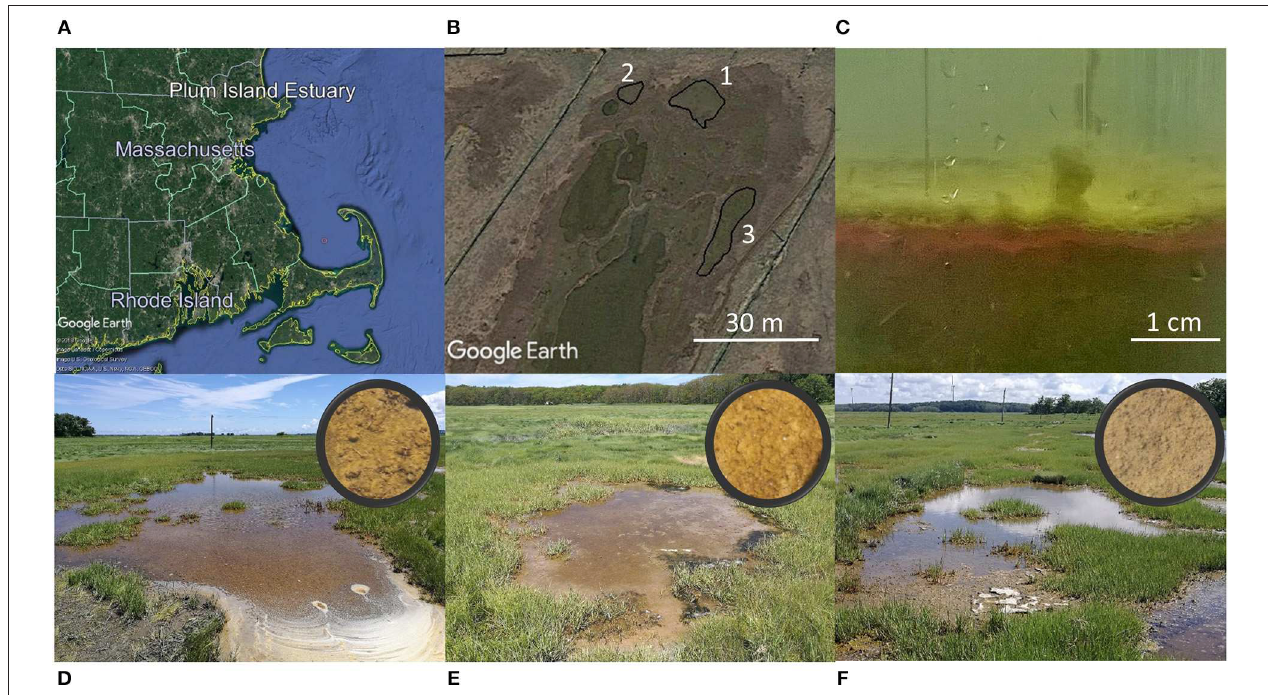
FIGURE 1 | Study site. (Top panel) Plum Island Estuary in Massachusetts, USA (Image: © 2018 Google. Image Landsat/Copernicus. Image U.S. Geological Survey. Data SIO, NOAA, U.S.Navy, NGA, GEBCO) (A) . Investigations were conducted in three closely located tidal ponds (image from Google Earth) (B) . A thick layer of photosynthesizing benthic microalgae covered the bottom of the tidal ponds (C) . (Bottom panel) The three ponds investigated are located on the marsh platform. Circles show close-up images of the sediment surface (D–F) .